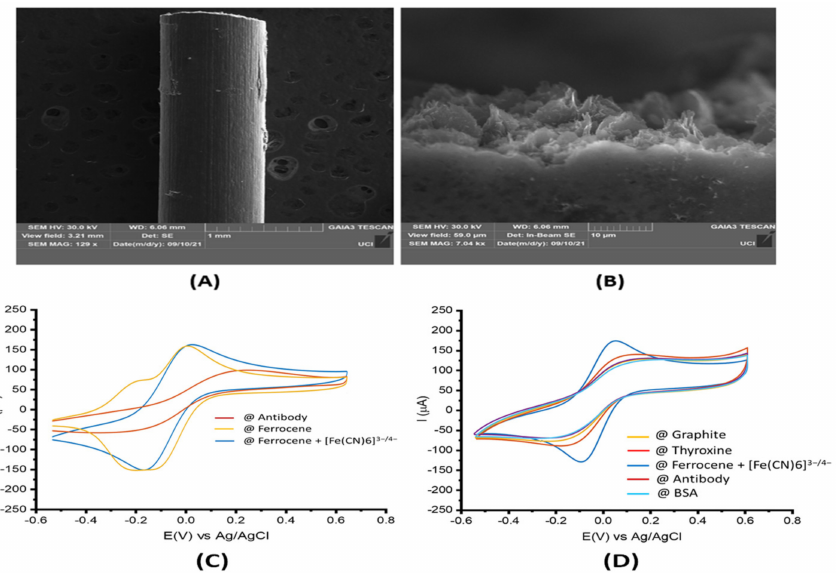
Figure 2. Characterization of the pencil graphite electrode. ( A ) SEM image of the bare 0.7 mm pencil graphite electrode surface at 129 × magnification. ( B ) SEM image of the 0.7 mm pencil graphite electrode after functionalization with Thyroxine and Ferrocene at 7.04 kx magnification. ( C ) CV was recorded for each bioconjugation step of the working electrode in a solution of 5.0 mM [Fe(CN)6] − 3/ − 4 containing 100 mM KCl as the supporting electrolyte at a scan rate of 50 mV · s − 1 . Ferrocene solution was prepared in acetonitrile with 0.1 M KCl electrolyte-supported solutions. ( D ) Electrochemical properties of the electrode surfaces after each step of the surface